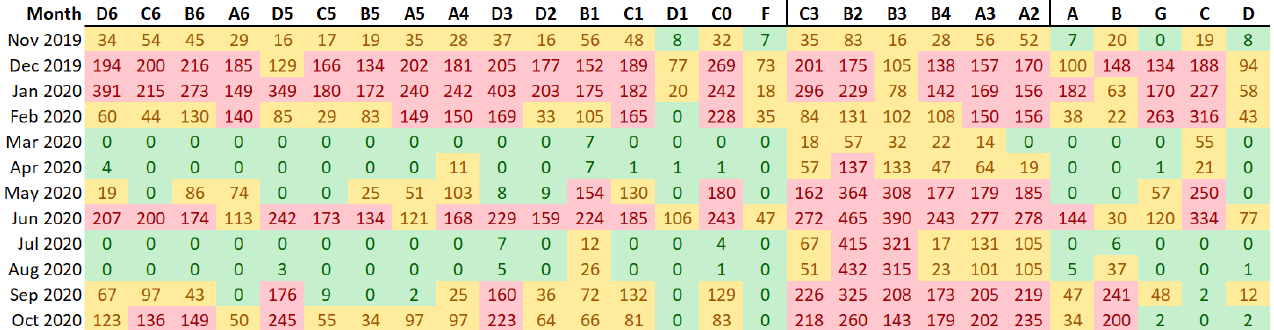
16 of 21 Figure 10. Band width (i.e., separation of security limits) for each data-logger according to EN 15757:2010. Each microcli- mate is represented by a different color (same as in Figure 1): the central area under the skylight in red; the ruins of the Andalusian period in blue, and the rest in green. In order to detect time periods and areas in the museum with excessive short fluctu- ations, the number of out-of-band values for each data-logger provides useful infor- mation, but this approach is time consuming and does not provide a general overview of the results. It is also convenient to study the short fluctuations using a common band width for all data-loggers, instead of considering a different band width for each one. This consensus criterion was established as the median of the set of bands, 2.50 °C. Next, out- of-band fluctuations were calculated again. According to Figure 9, by applying the standard individually to each data-logger and computing the number of out-of-band observations, the differences between data-loggers are not clearly marked except in the case of B2 and B3. Given that the use of a different band width does not provide a clear overview of the differences, the results were recalcu- lated after establishing a common criterion for the bandwidth (Figure 11). Results indicate